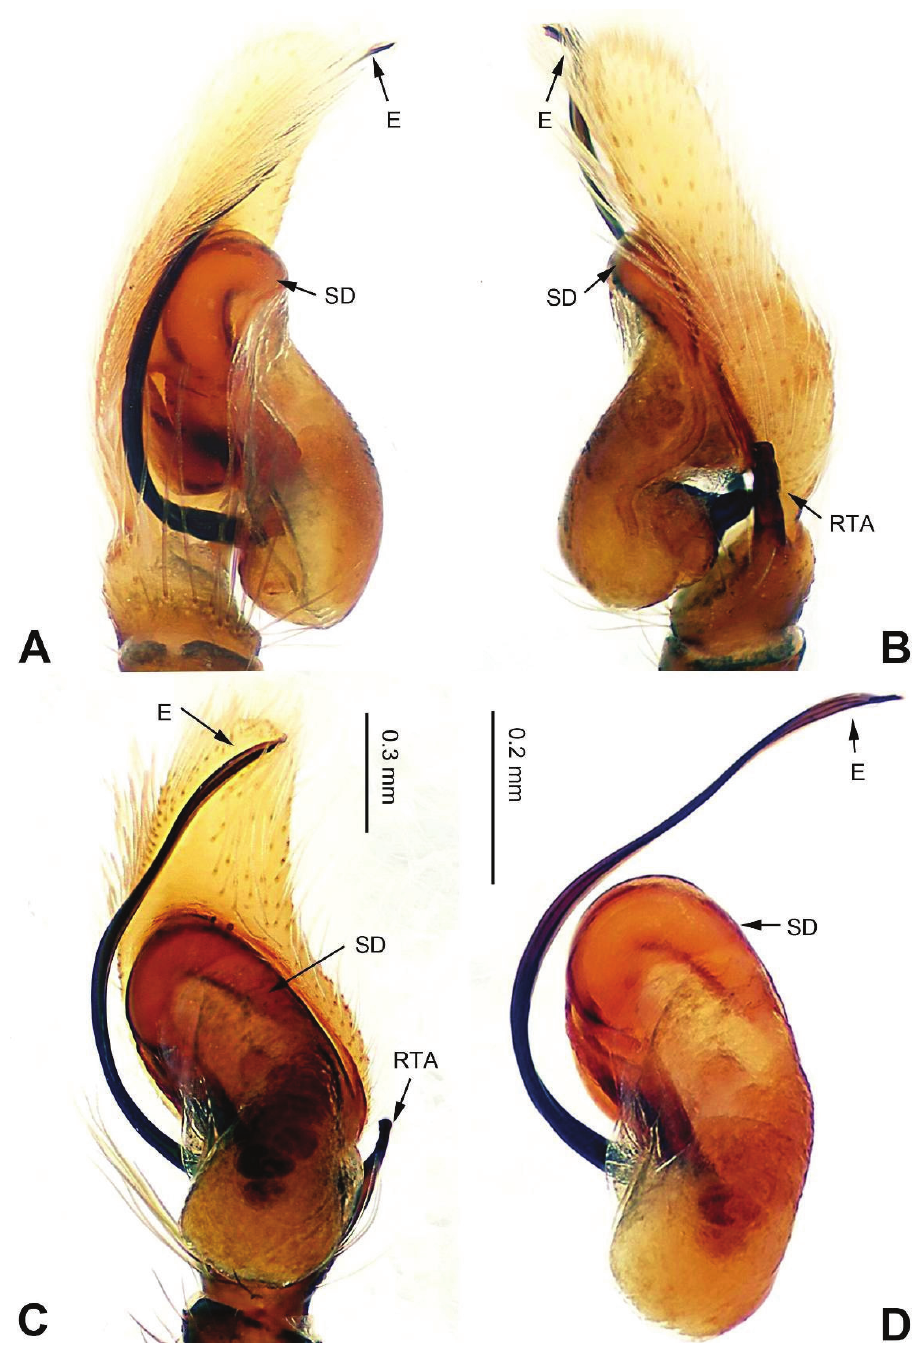
Figure 28. Palp of Nannenus menghaiensis sp. n., male holotype. A prolateral B retrolateral C ventral D bulb, ventral. Scale bar equal for A–C